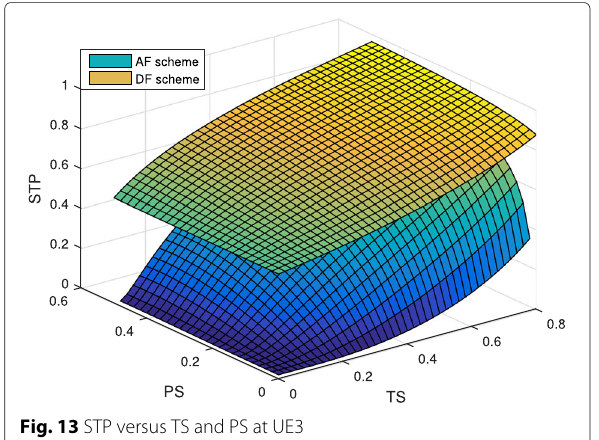
Fig. 13 STP versus TS and PS at UE3